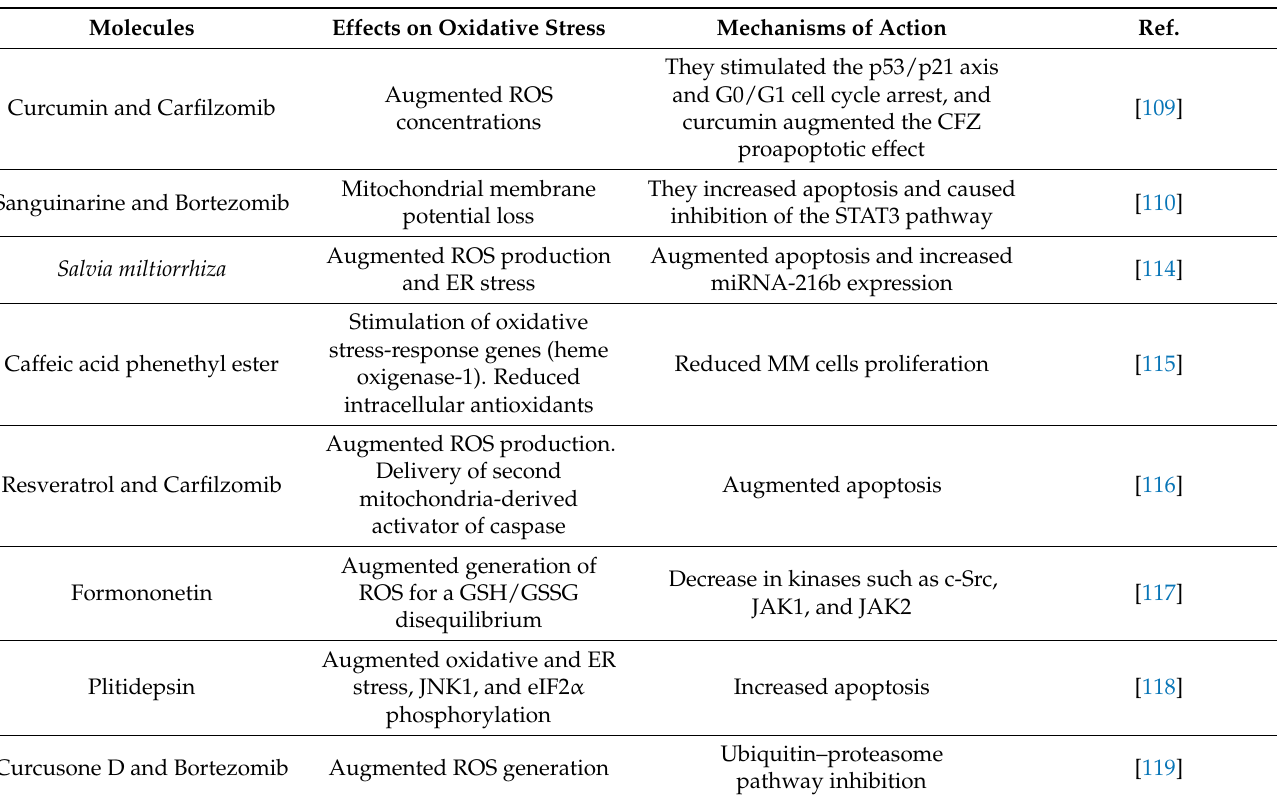
Table 2. Effects of substances of natural origin in the modulation of oxidative stress in multiple myeloma, mechanisms of action, targets, and synergistic effects with proteasome